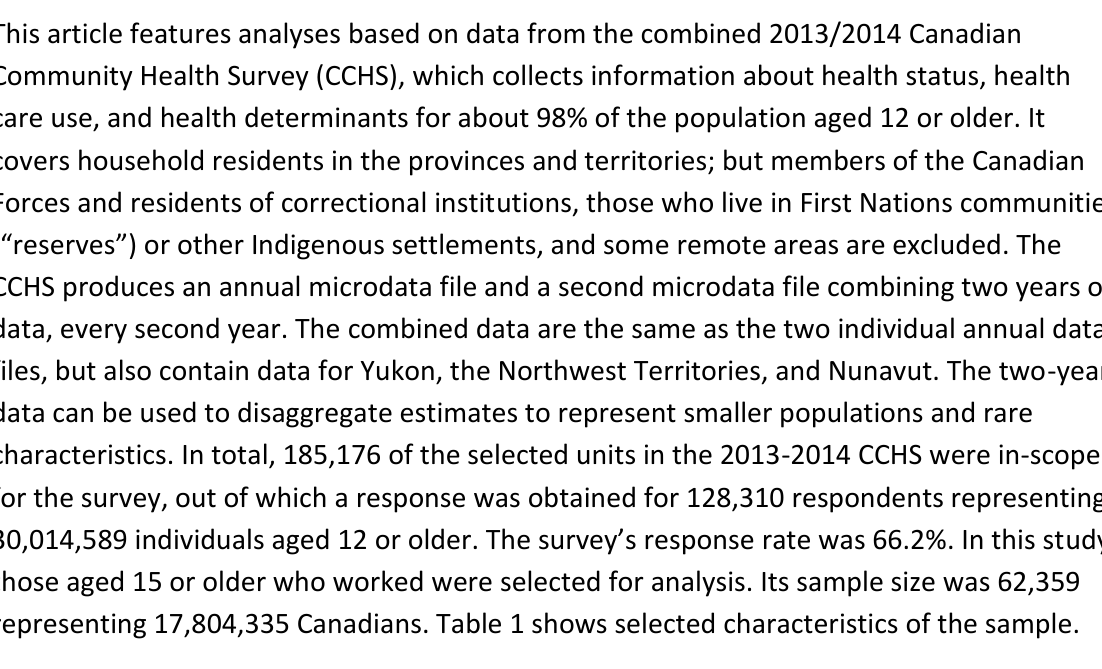
Table 1. Occupational distribution of Case study professions, aged 15+, Canada,